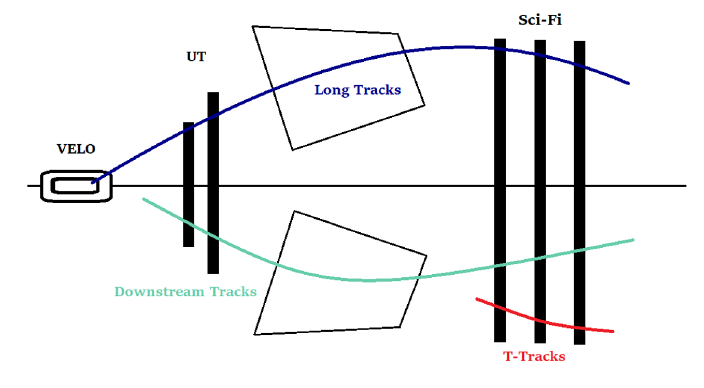
Figure 1 . Schematic drawing of the LHCb detector with the different types of tracks that are considered in this